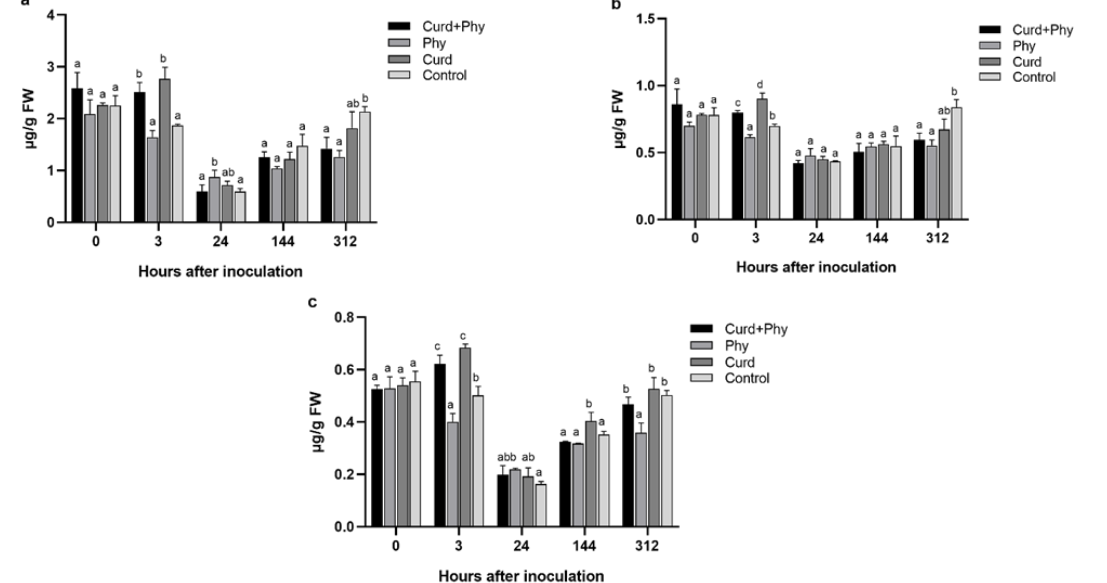
Figure 4. Effect of Curd treatment on ( a ) chlorophyll a, ( b ) chlorophyll b and ( c ) carotenoids from avocado plant leaves inoculated with P. cinnamomi . Curd+ Phy, Phy, Curd, and Control represent the application of Curd one day before inoculation of P. cinnamomi , inoculation of P. cinnamomi , application of Curd without inoculation of P. cinnamomi and the control (distilled water), respectively. Data are presented as the mean ± standard deviation for nine replicates. Means with the same letter are not significantly different (ANOVA followed by Tukey’s test at p < 0.05).